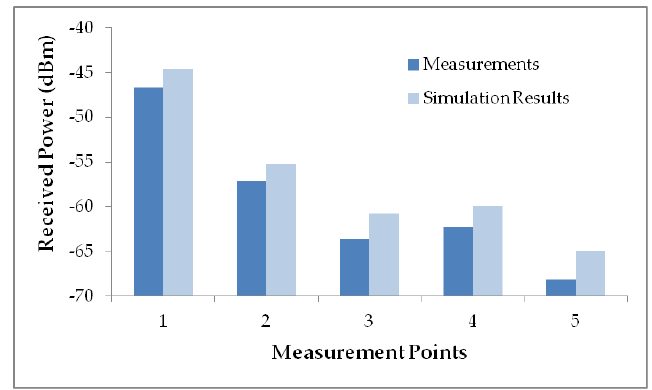
Figure 9. Measurement vs simulation results when the Xbee prototype is attached to the dog within the scenario under analysis.